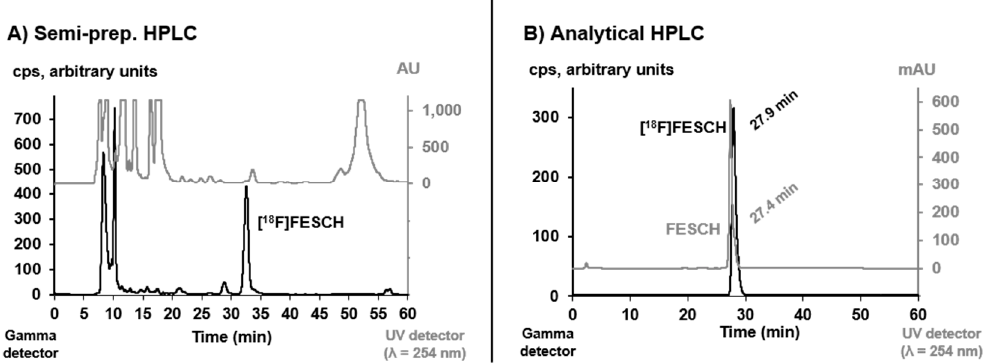
Figure 2. ( A ) Semi-preparative HPLC profile of the crude reaction mixture for isolation of [ 18 F] FESCH (column: Reprosil-Pur 120 C18-AQ, 250 × 10 mm, particle size: 10 µm, eluent: 50% MeCN/20 mM